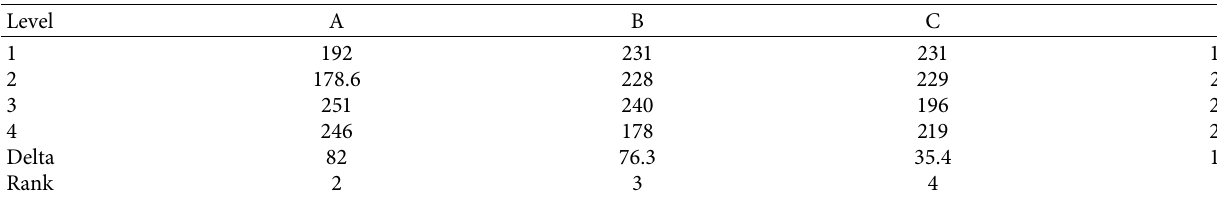
Table 5: Means values.